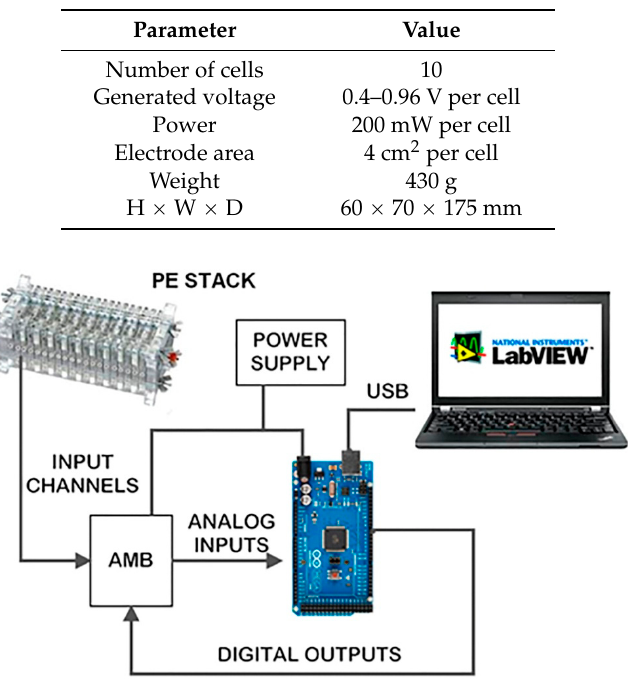
Table 1. Main features of the PE stack.